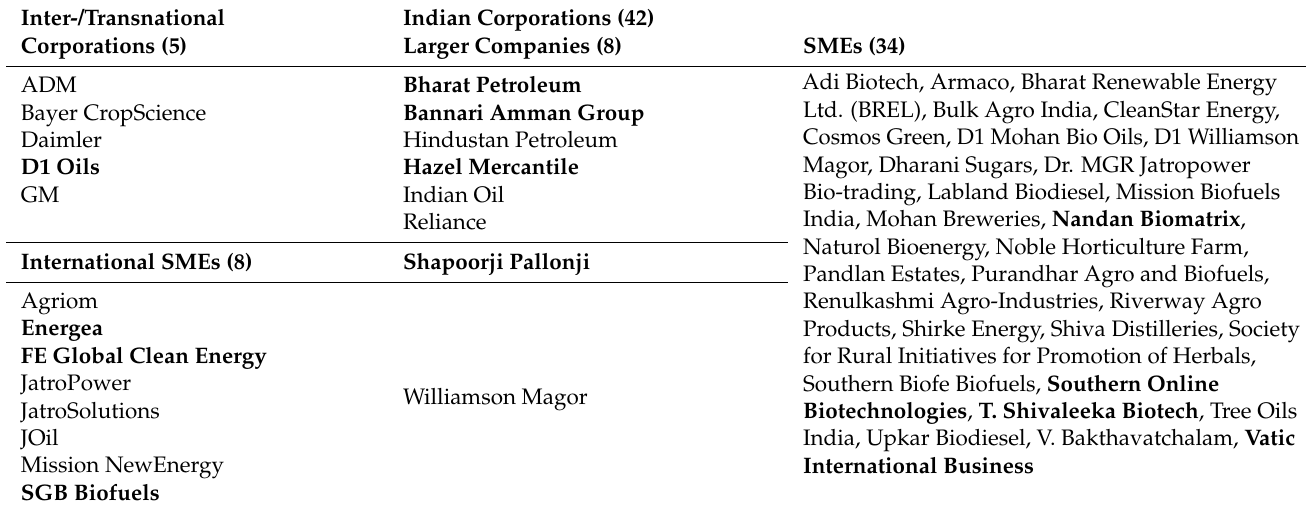
Table 1. Companies that had jatropha projects in India between 2000 and 2015 (company names in bold font indicate that this company was listed in the Land Matrix as being involved in land grabbing processes); source: author’s survey and Land Matrix [22], (data of